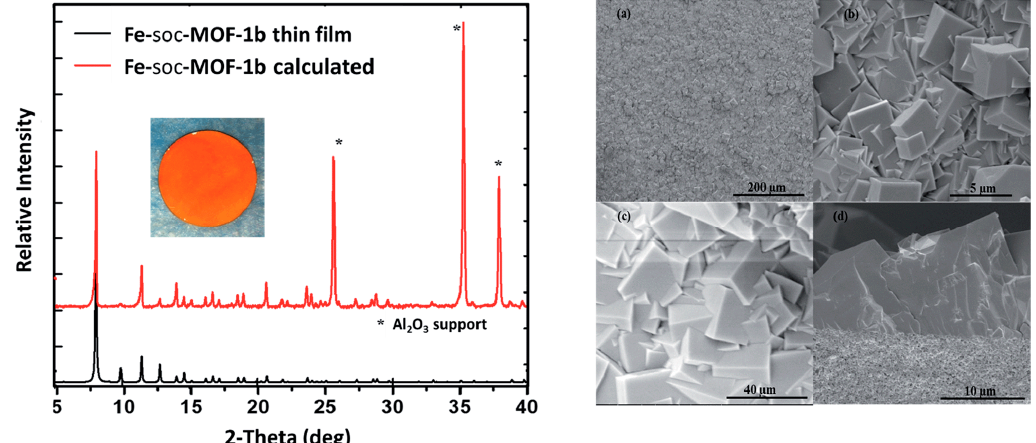
Figure 69. ( Left ) Fe- soc -MOF-1b membrane grown on alumina support and its PXRD pattern compared to the bulk material. ( Right ) Top-view ( a – c , d ) cross-sectional SEM images of the Fe- soc -MOF membrane grown on the alumina support (adapted with permission from ref. [167]).